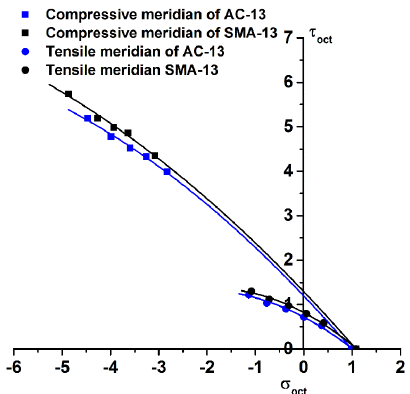
Table 4. Parameters of the nonlinear failure criterions.